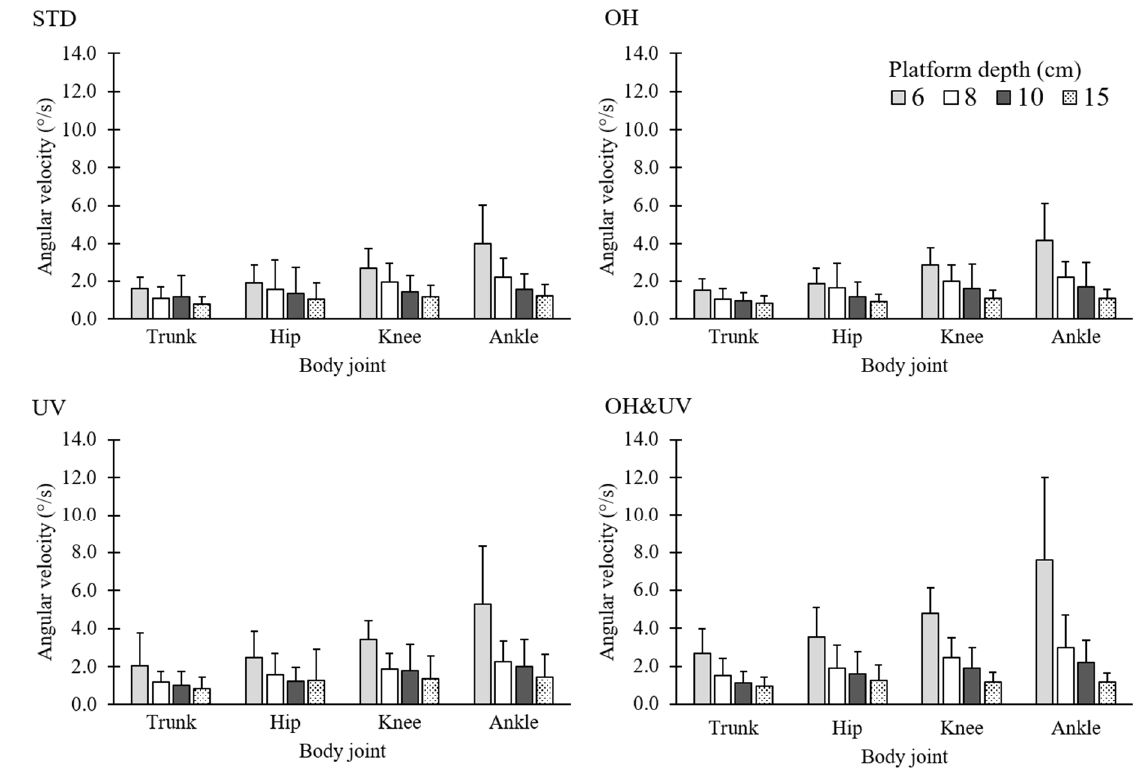
Figure 8. Angular velocity for the trunk, hip, knee, and ankle.